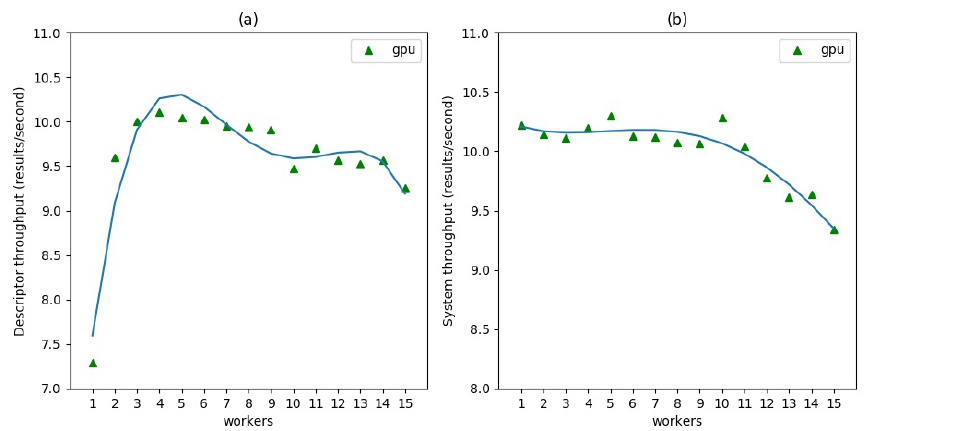
Figure 8. Scalability of a single Descriptor chain increasing the number of workers in GPU mode. ( a ) Descriptor throughput. It indicates the number of feature updates per second. ( b ) System throughput. It indicates the number of output messages per